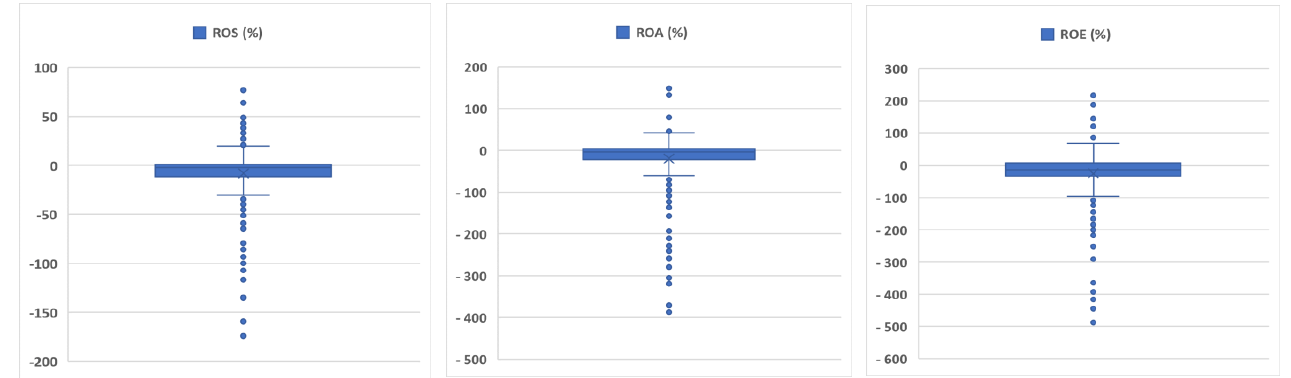
Figure 1. Distribution of the ROS, ROA and ROE averages (%) for Hungarian companies without outliers. Source: Authors ’ own editing, based on own calculations.